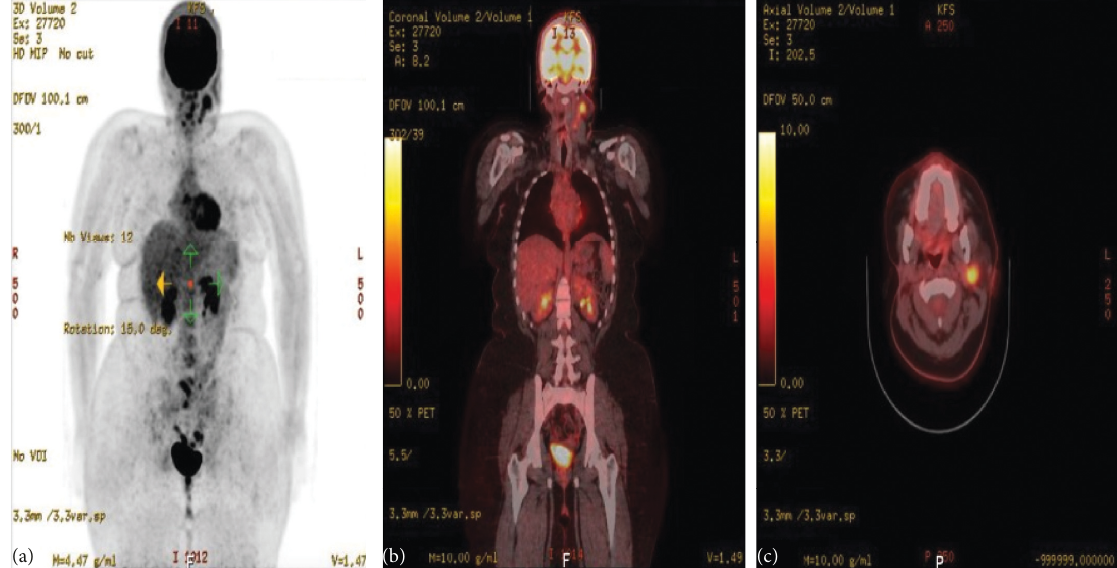
Figure 6: The PET scan in August 2020. The study showed an interval anatomic increase in size and metabolic progression in the known suspicious left deep parotid lesion ((a)–(c)). Measure approximately 2.0 × 1.9 × 2.2 cm in anteroposterior, transverse, and craniocaudal dimensions, respectively, with standard uptake value max (SUVmax) of 3.2. The SUVmax was previously 2.2. On the other hand, there is a more prominent left infraparotid subcentimeter node showing mild fluorodeoxyglucose (FDG) uptake. SUVmax 1.2 is indeterminate. Moreover, an anatomically stable mild FDG-avid left jugulodigastric subcentimeter node with SUVmax up to 1.4 and right supraclavicular node (SUVmax 1.0) are nonspecific, likely reactive. No other size significant FDG-avid cervical